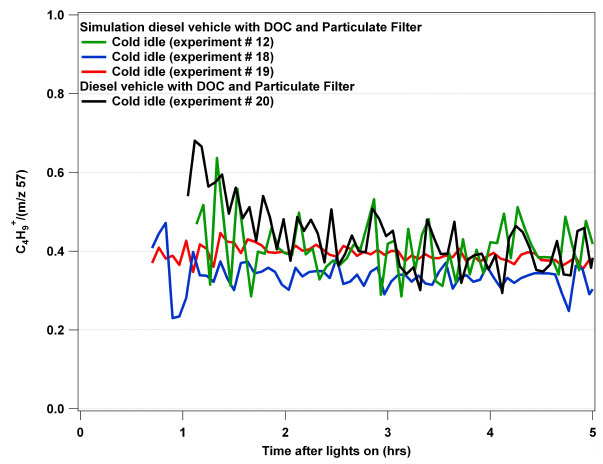
Fig. 10. Time series of the fraction of C 4 H + from the diesel gas-phase only